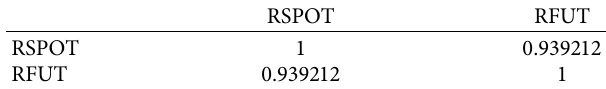
Table 2: Karl Pearson’s